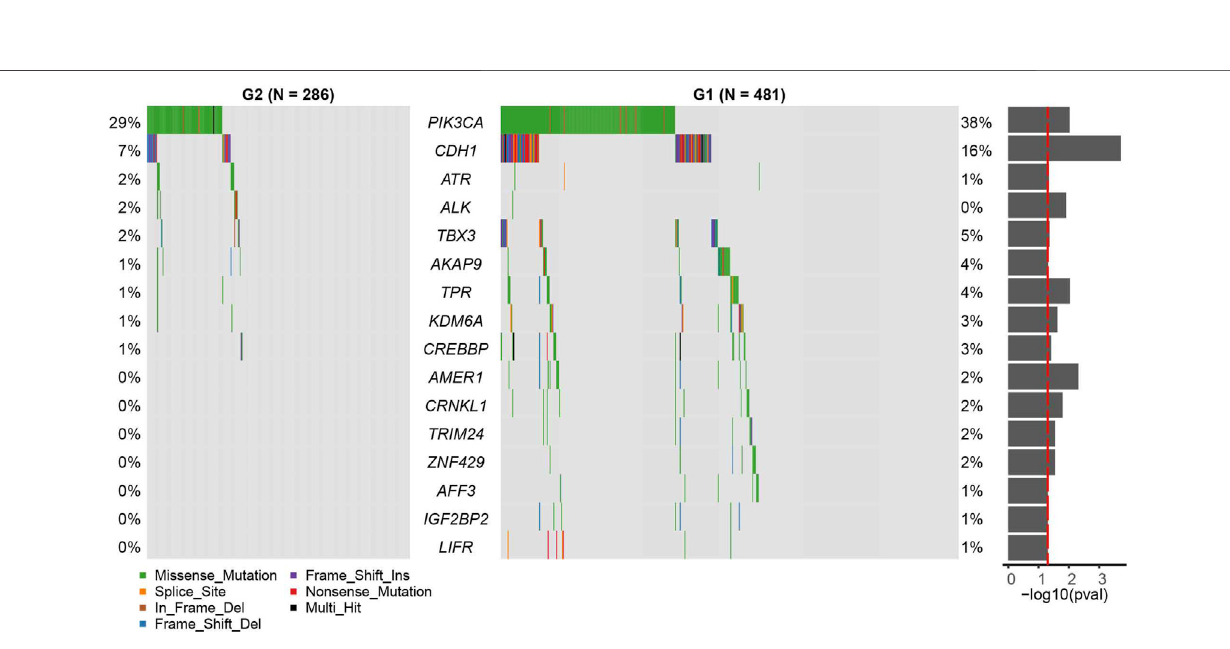
Frontiers in Genetics |